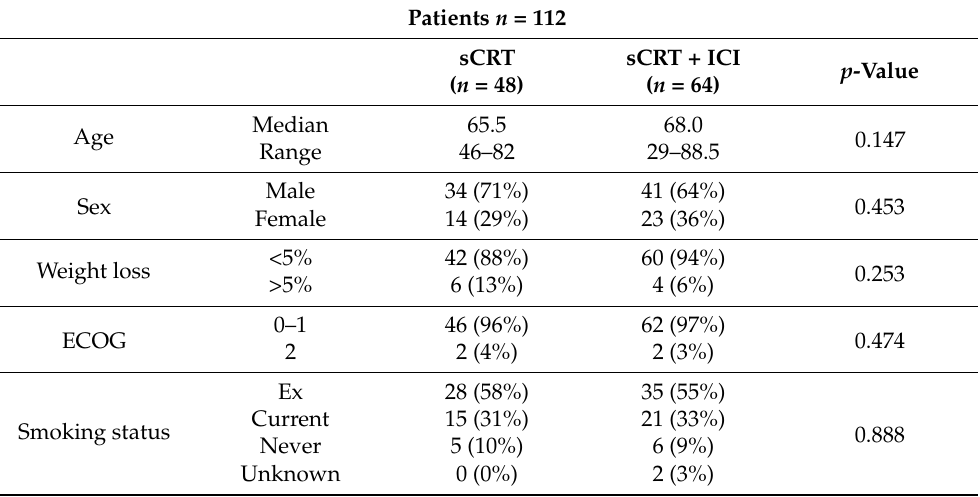
Patients stratified by immunotherapy (sCRT = sequential chemoradiotherapy, ICI = immune checkpoint inhibitor, n.a. = not assessed). The comparison between subgroups was calculated using the Mann–Whitney U